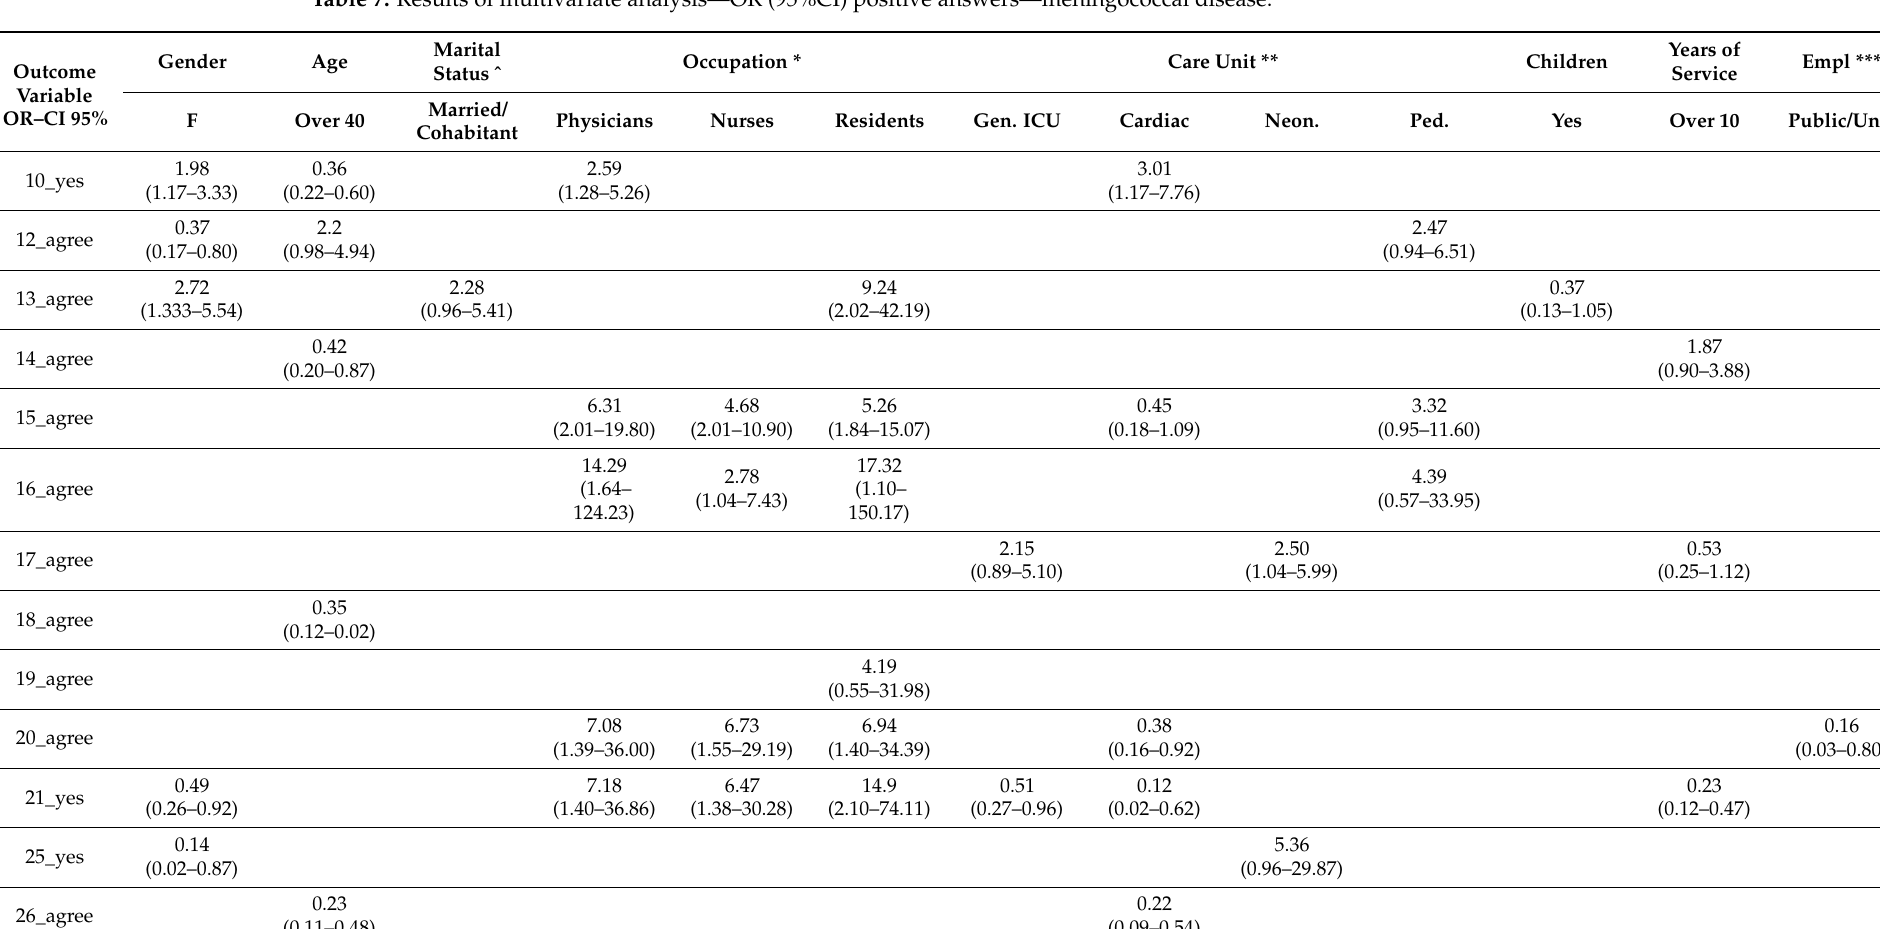
Table 7. Results of multivariate analysis—OR (95%CI) positive answers—meningococcal